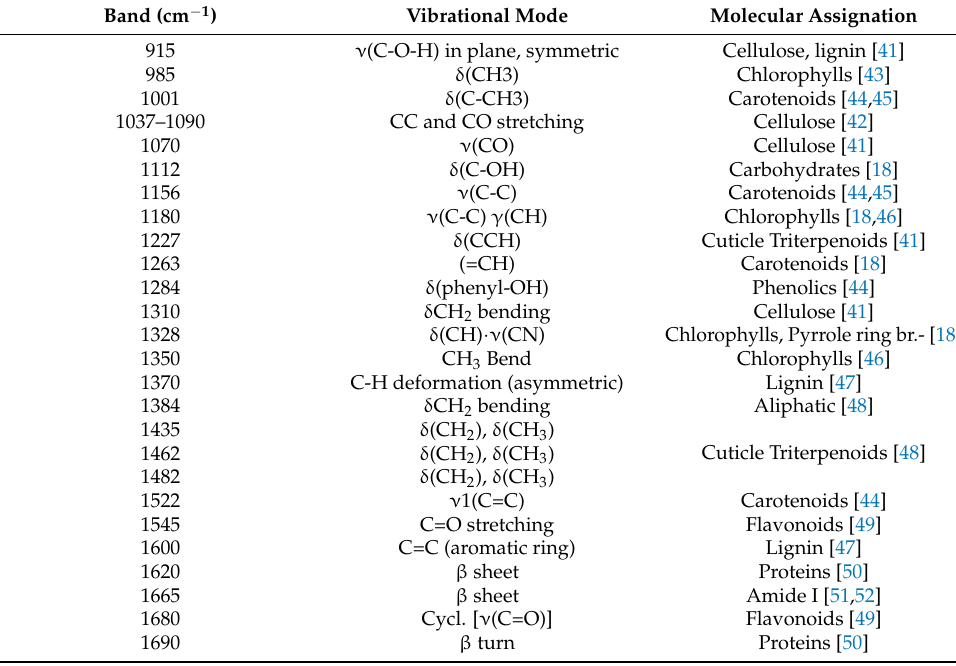
Table 1. Vibrational bands and their assignments for tomato